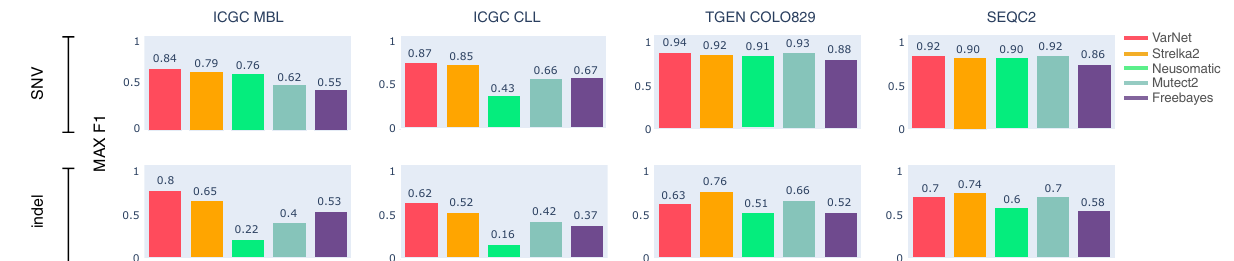
Fig. 3 Variant calling accuracy across real tumor datasets. Maximum F 1-accuracy scores achieved by methods on real tumor benchmark samples (MBL: medulloblastoma, CLL: chronic lymphocytic leukemia, COLO829: melanoma, SEQC2: breast cancer) for SNV calling (top) and indel calling (bottom). Source data are provided as a Source Data fi le.